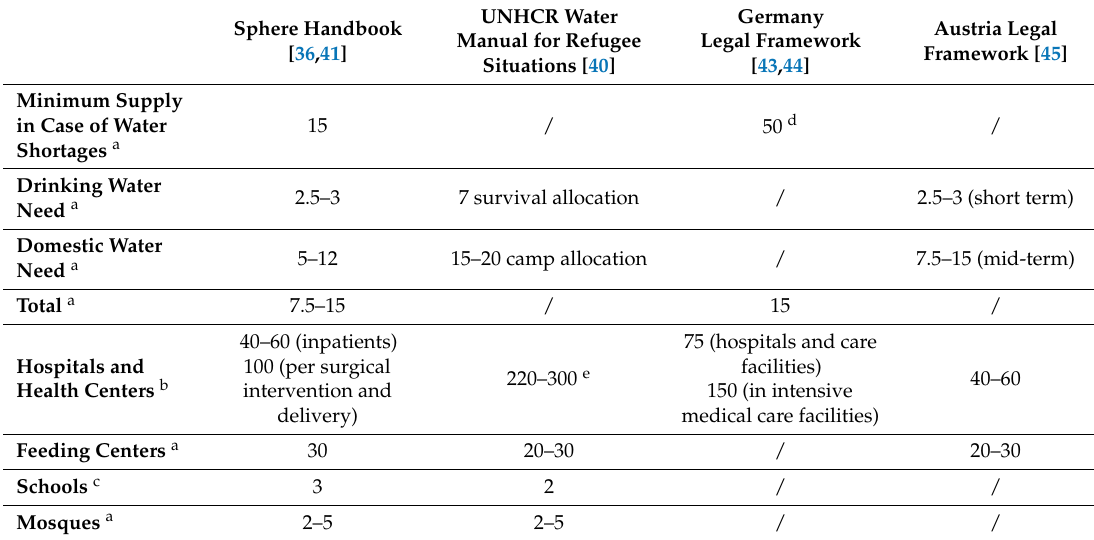
Table 2. Water demands according to Sphere [36,41], UNHCR [40] Handbooks and German [43,44] as well as Austrian [45] legal frameworks.